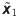
Evolution of x˜1 and x˜2 as a function of the participant number i.The vertical dashed lines indicate the instant in which we forced x˜1=90 (i = 3637). The two horizontal lines indicate the values of x˜1 and x˜2 that optimize the avatar’s appearance as obtained from the first phase of the experiment. The avatars below the graph show the starting and arriving points of the two phases of the experiment.